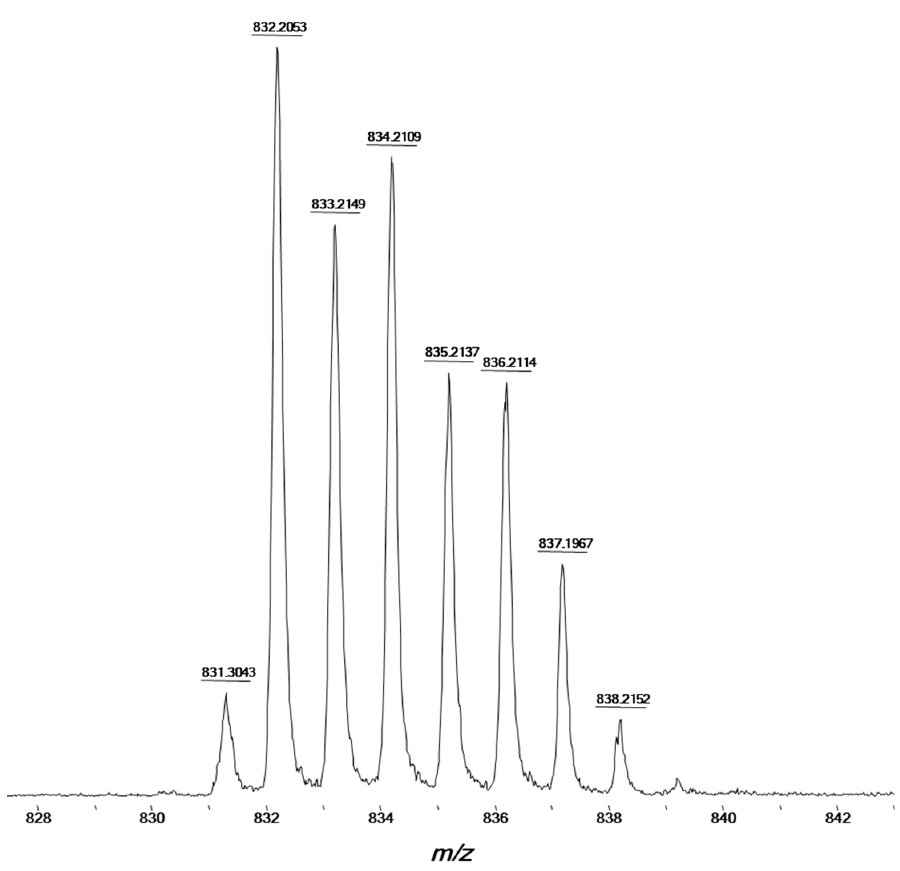
Figure 3. HRMS-MALDI-TOF of 10 .